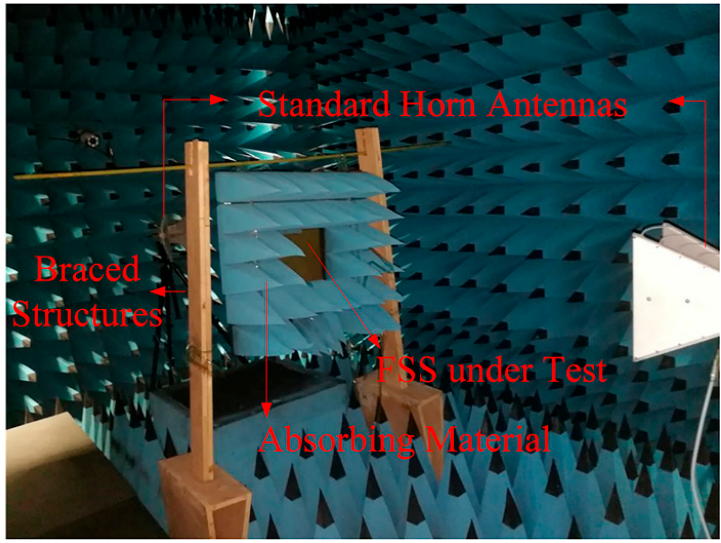
Figure 5. The test environment of FSS under test (FUT).